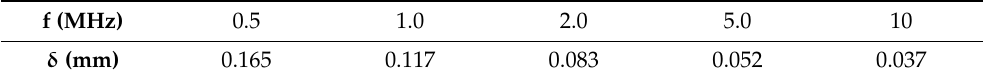
Table 1. Standard depth of penetration for 7075-T6 aluminum alloy with various frequencies. f (MHz) 0.5